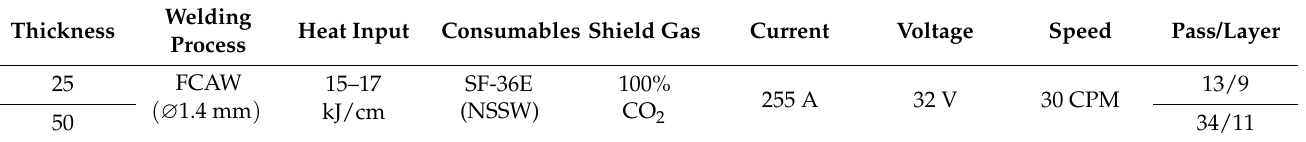
Table 4. Welding conditions for thicknesses of 25 and 50 mm.